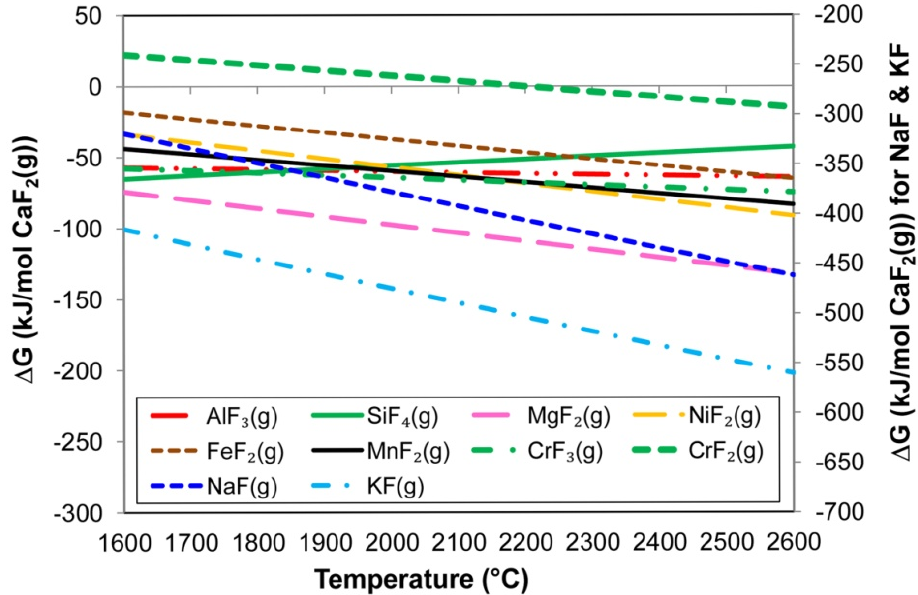
Figure 5. Gibbs free energy values of reactions similar to Equation (11).